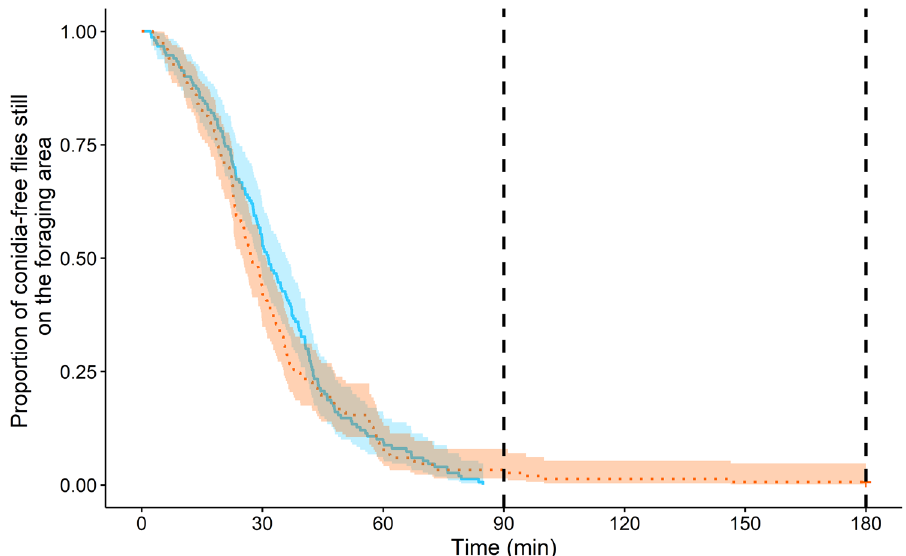
Figure 7. Collective experiment: the proportion of dead flies still on the UFA (in blue) and on the CFA (in orange) as a function of the time (min). The coloured shadings surrounding lines represent the 95% confidence interval. Curves were drawn by pooling all the conidia-free prey given on each platform for the ten tested colonies (N = 150 dead prey). The two vertical dashed lines indicate the half (i.e., 1 h 30) and the end of the experiment (i.e., 3